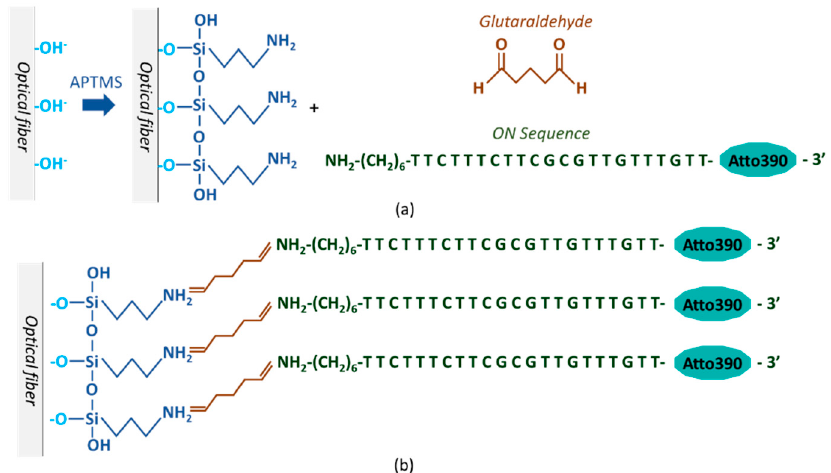
Figure 1. ( a ) Immobilization process of the ON sequence onto the surface of the optical fiber: first, the OH − groups were activated with piranha solution, then the surface was silanized with APTMS and finally, the ON sequence was cross-linked utilizing glutaraldehyde. ( b ) Schematic of the sensing structure.